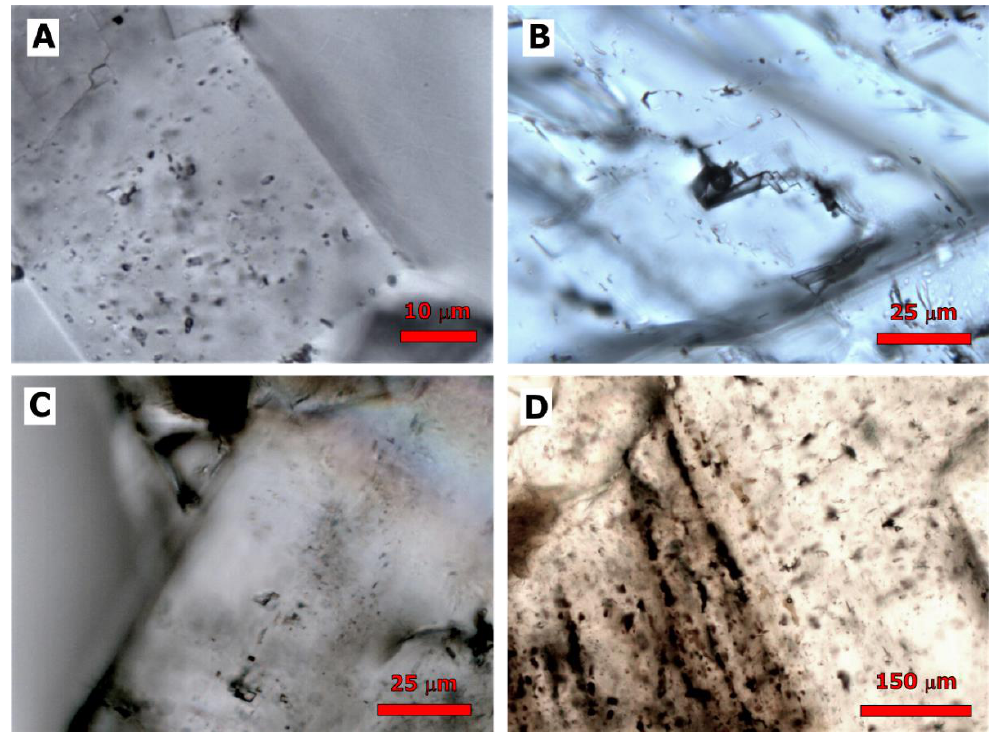
Figure 13. Fluid Inclusion assemblages. ( A ) Photomicrograph (PPL) of fluid inclusion assemblage in an RD2 crystal from Lucas Formation. Sample 1-3-2; Well: DGR1-CR2 (2); depth: 26.95 m; ( B ) photomicrograph (PPL) of isolated two-phase, primary fluid inclusions (liquid-rich with vapor bubble) hosted within blocky calcite cement occluding fractures in the Lucas Formation. Sample 8-1; Well: DGR8-CR10; depth: 22.71 m; ( C ) photomicrograph (PPL) of fluid inclusions assemblage in RD2 along the crystal growth showing two-phase primary fluid inclusions. Sample 1-31; well: DGR1-CR133; depth: 378.1 m; ( D ) photomicrograph (PPL) of fluid inclusion assemblage in SD along the crystal growth, showing a trail of two-phase primary fluid inclusions with irregular and elongated shapes. Sample 1-28; well: DGR1-CR121; depth: 342.27 m. Fluid inclusions hosted in RD2 from Silurian samples show higher T h and salinity compared to fluid inclusions hosted in RD2 from Silurian formations. Microthermometric results of pervasive, replacive medium crystalline dolomite matrix (RD2) vary from T h : 49.7 to 134.1 °C (average: 89.1 ± 20.9), 22.03 to 25.2 wt.% NaCl eq. (average: 23.3 ± 1.1) and T h : 69.9 to 102.3 °C (average: 82.7 ± 9.8), 18.9 to 21.8 wt.% NaCl eq. (average: 20.8 ± 0.9) for the Silurian and Devonian samples, respectively. Saddle dolomite (SD) hosted in Silurian successions shows values ranging from T h : 101.2 to 193.4 °C (average: 124.8 ± 20.5), 25.97 to 32.6 wt.% NaCl eq. (average: 28.5 ± 1.8). Fluid inclusions hosted in BKC from Silurian samples show lower T h and higher salinity compared to fluid inclusions hosted in BKC from Silurian formations. In late calcite cement (BKC), measured values range from T h : 70.2 to 194.3 °C (average: 120.9 ± 35.4), 21.4 to 32.3 wt.% NaCl eq. (average: 27.6 ± 3.2) and T h : 146.20 to 237.9 °C (average: 194.87 ± 26.9), 15.17 to 23.95 wt.% NaCl eq. (average: 20.21 ± 2.31) for the mentioned age groups, respectively.